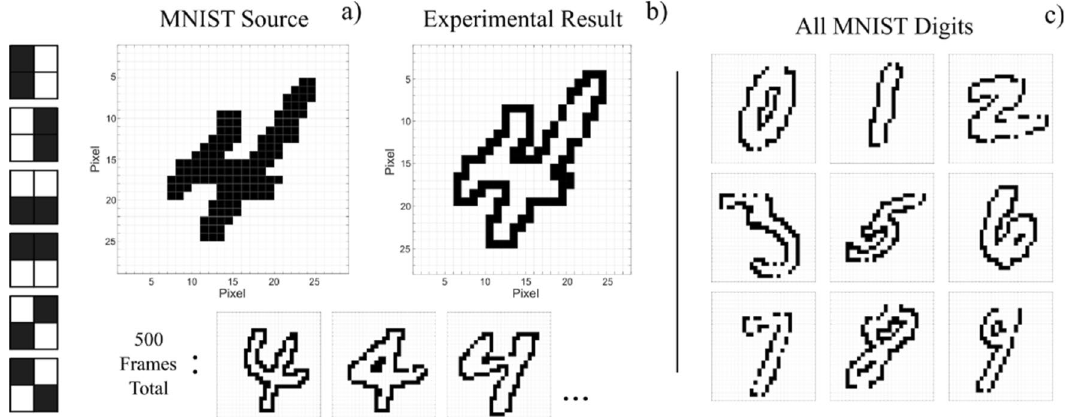
Figure 5. MNIST handwritten-digit edge detection with an integrate-and-fire VCSEL neuron. Six 2 × 2 symmetrical kernels (2 vertical, 2 horizontal, 2 diagonal) we applied to 500 images of each digit from the MNIST dataset. All kernels are sequentially applied to the source image (a) which, when analysed and combined, produce reconstructions (b) that reveal all edge information. Each set of MNIST digits (c) were processed separately.